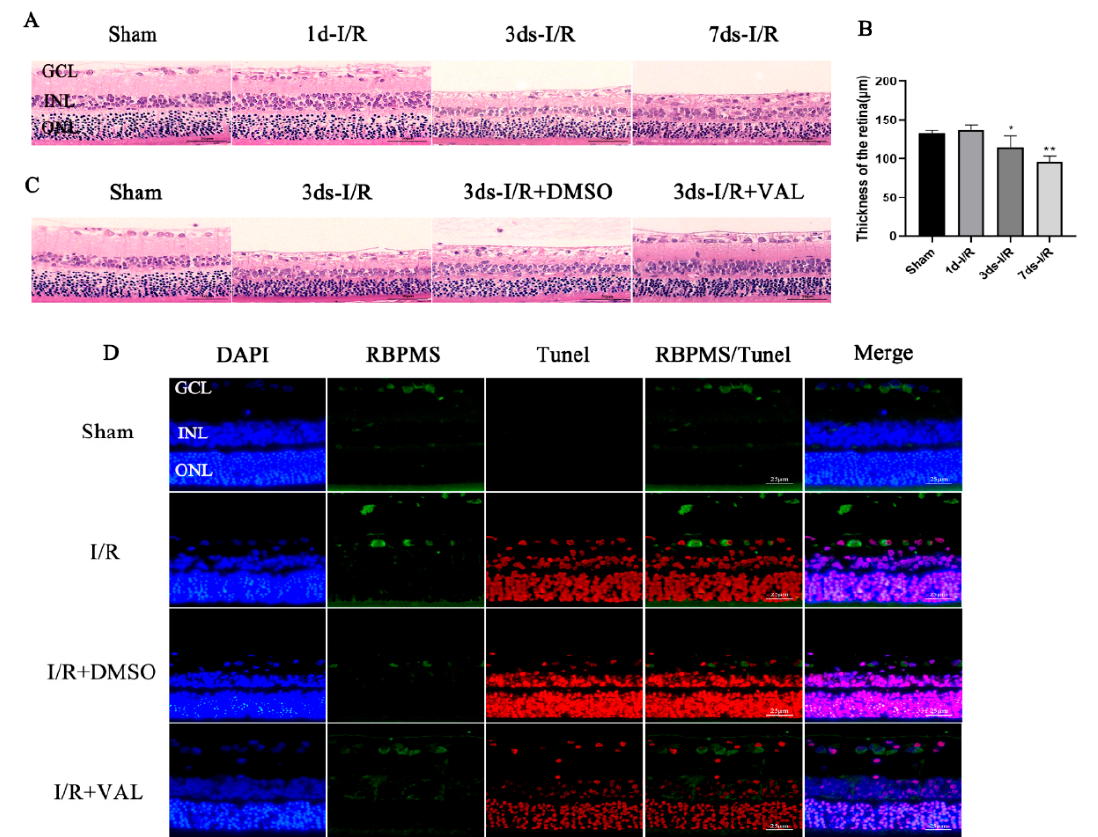
Figure 2. Valdecoxib alleviates the morphological changes to the retina and reduces the number of TUNEL-positive RGCs in retinal ischemia-reperfusion injury. ( A ) Representative images of vertical sections obtained from retinas in the control, 1d-I/R, 3ds-I/R and 7ds-I/R groups, stained with hematoxylin (blue) and eosin (red). Scale bar = 50 µ m. ( B ) Quantification of the mean total thickness of the retina in the control and 1-, 3- and 7-day post-I/R groups. The retinas of the 3ds-I/R and 7ds-I/R groups were significantly thinner compared to those of the control group. ( C ) Representative images of vertical sections obtained from retinas in the control, 3ds-I/R, 3ds-I/R+DMSO and 3ds-I/R+VAL groups, stained with hematoxylin (blue) and eosin (red). Scale bar = 50 µ m. ( D ) Images obtained from retinas in the control, I/R, I/R+DMSO and I/R+VAL groups, stained with DAPI (blue), RBPMS (green) and TUNEL (red). Scale bar = 25 µ m. RBPMS was used to label RGCs, and TUNEL was used to label apoptotic cells. The data are presented as the mean ± SD of three independent experiments. Each group was composed of five rats. ** p < 0.01, * p < 0.05 vs. sham group.